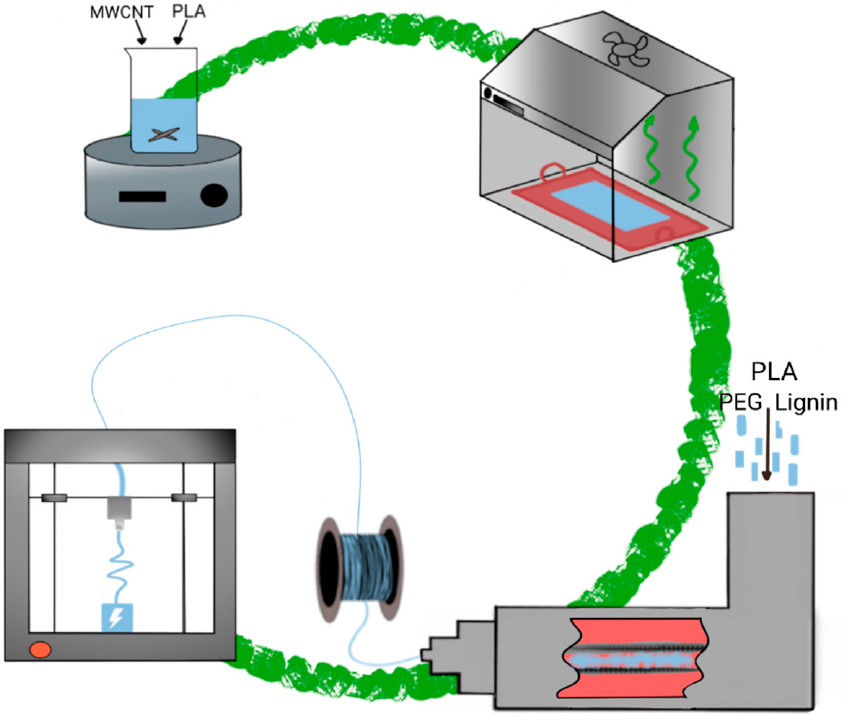
Figure 1. Flowchart of the polymer composites obtaining process: solvent casting (with the extractor hood), melt mixing, and 3D printing.